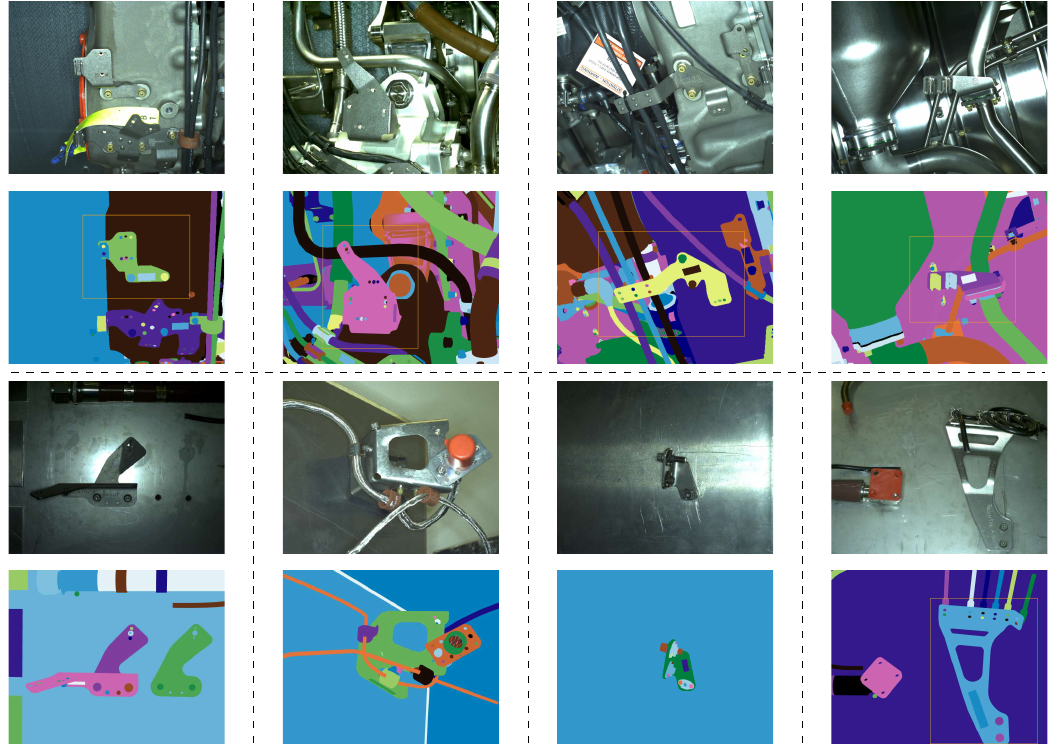
Figure 5. Examples of our dataset: (1st and 3rd rows) real images and (2nd and 4th rows) corresponding renders of CAD